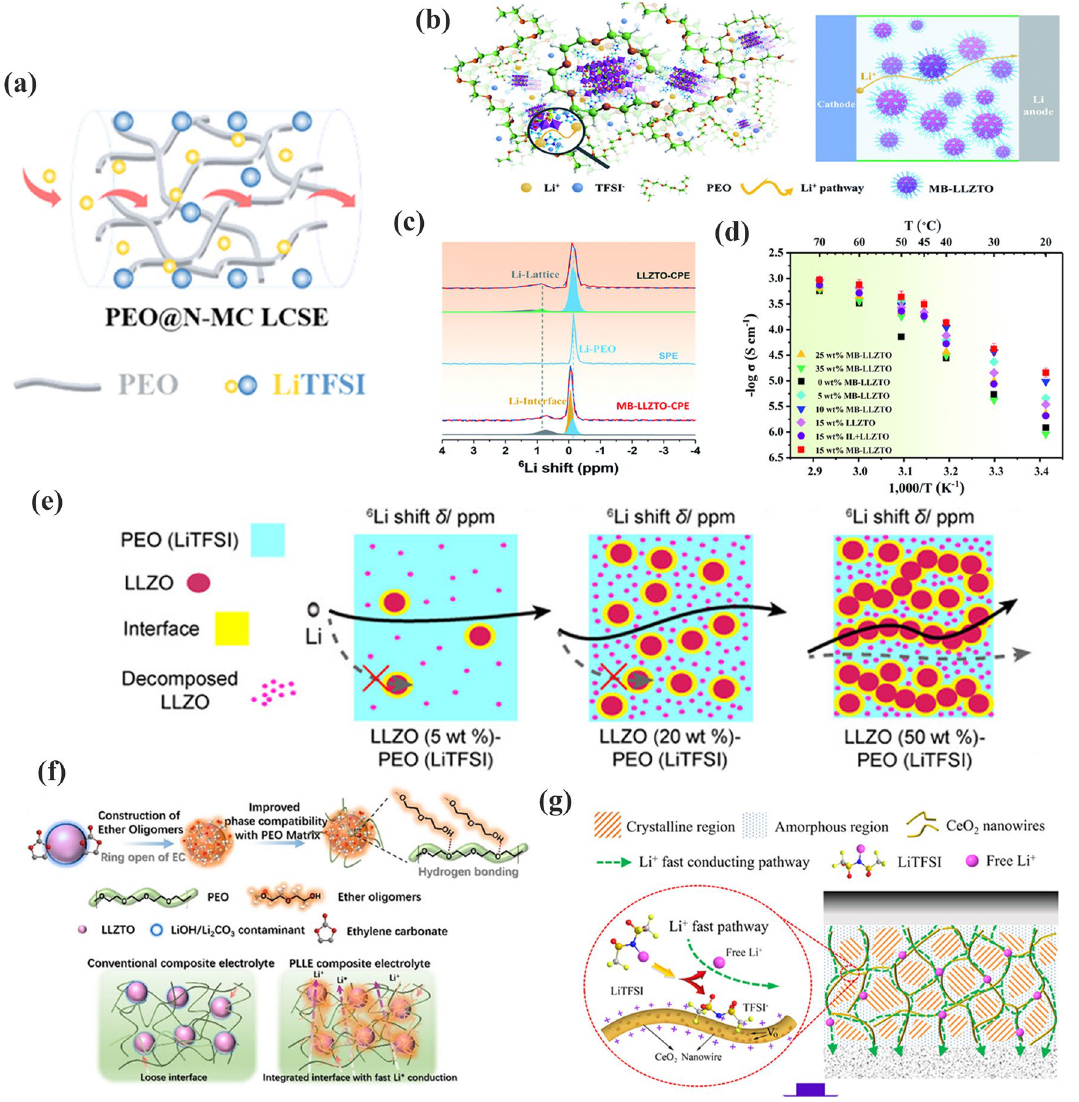
Fig. 10 a Schematic diagram of the lithium-ion transfer in PEO@N-MC. Adapted with permission from Ref. [133]. b Figure of diffusion route of lithium ions in MB-LLZTO CPE; c 6 Li NMR spectra of LLZTO CPEs and MB-LLZTO CPEs; d Ionic conductivity of MB-LLZTO CPEs. Adapted with permission from Ref. [100]. e Schematic representation of the lithium-ion route within LLZO (5–50 wt%)-PEO (LiTFSI). Adapted with permission from Ref. [135]. f Intermolecular interact on mechanism of LLZTO with in PEO. Adapted with permission from Ref. [136]. g Illustration of CeO 2 NW-CPEs. Adapted with permission from Ref.